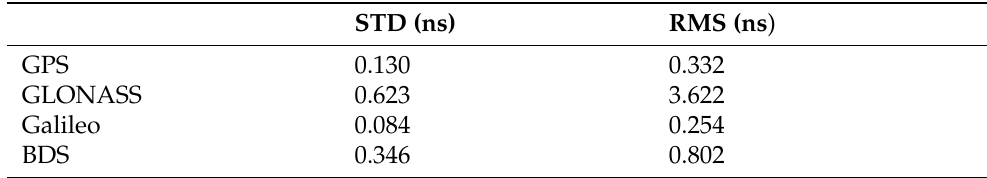
Figure 8. STD and RMS values of CLK93 products’ clocks with reference to the GFZ’s final products. Table 4. Eleven–day mean STD and RMS values of CLK93 products’